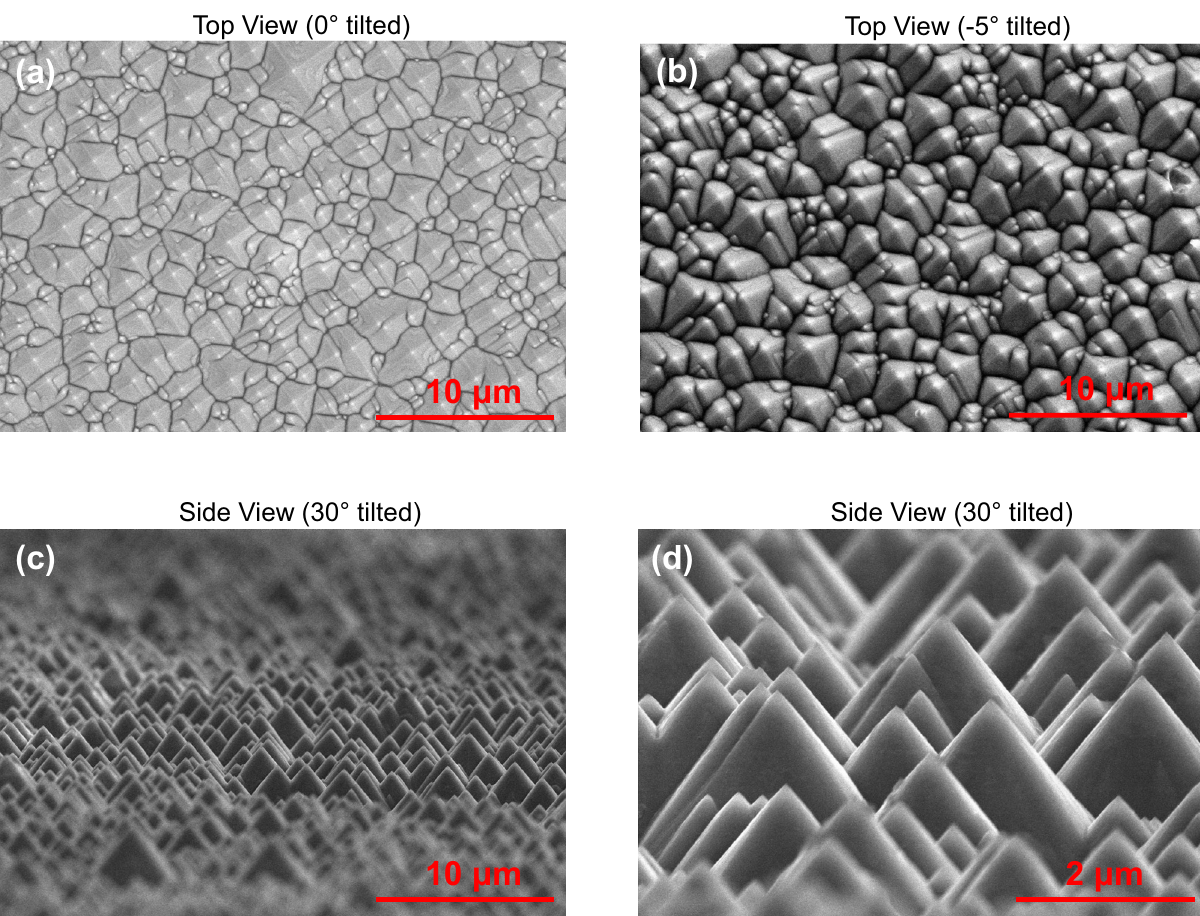
Figure 6. SEM images of textured silicon (100) wafer surface after the anisotropic etching: ( a ) top view, ( b ) top view with sample tilted at − 5°, ( c ) side view with sample tilted at 30°, ( d ) side view with sample tilted at 30° by high